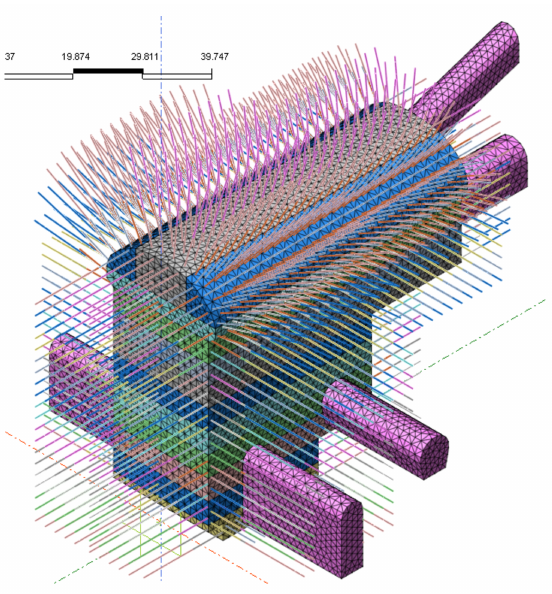
Figure 4. Reinforcement system adopted in the three-dimensional numerical